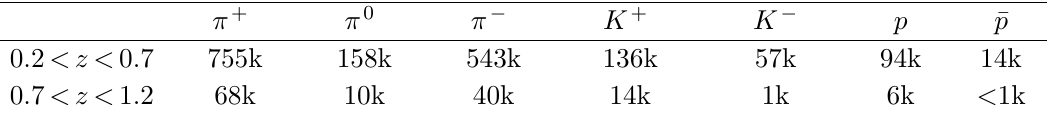
Table 4 . Hadron yields for the semi-inclusive DIS range and the high- z